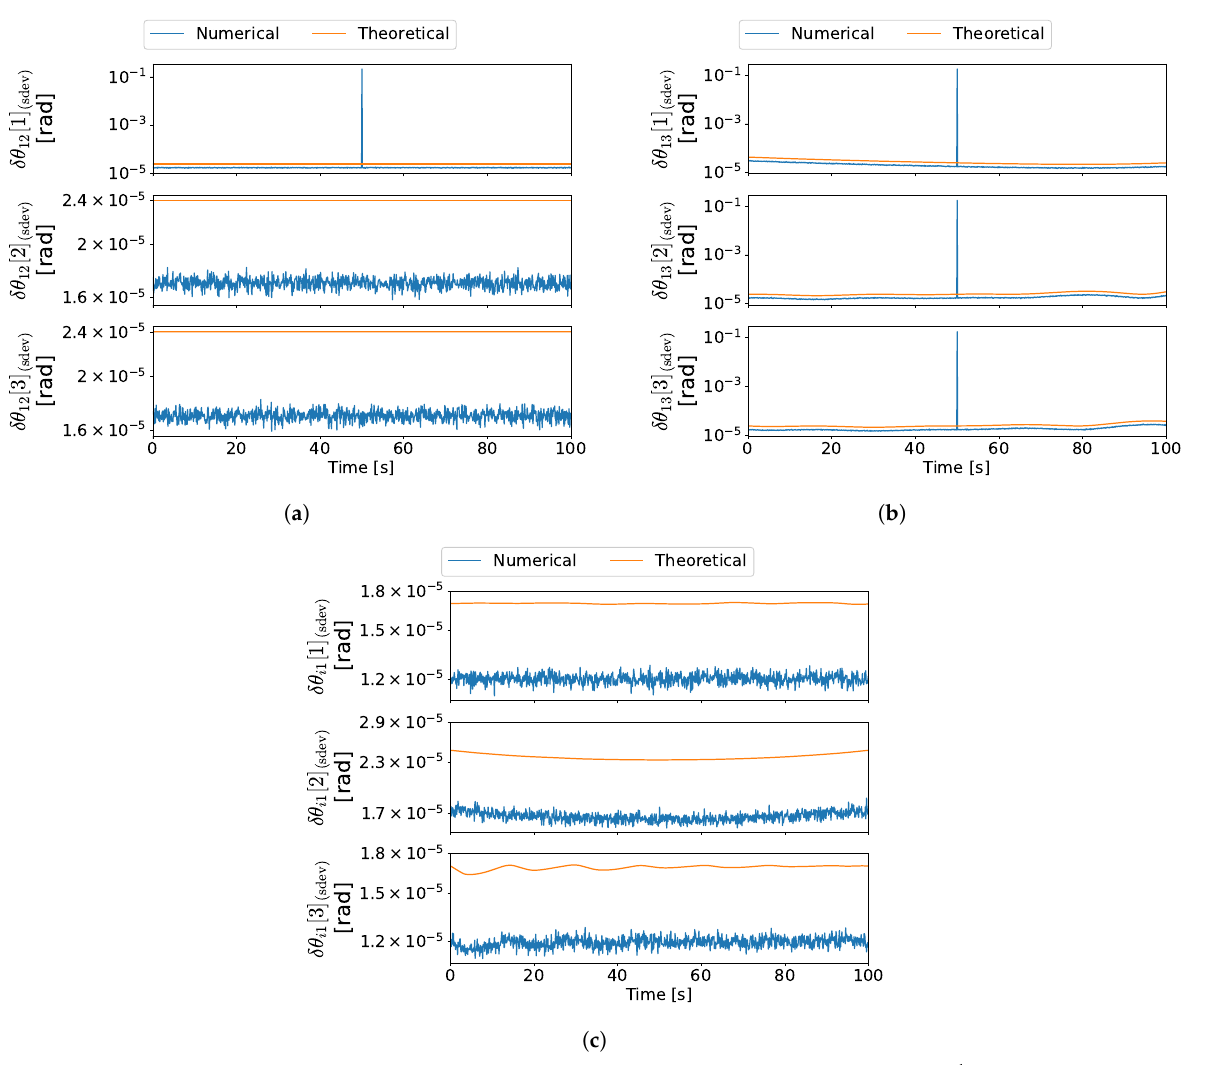
error standard deviation in 2 error standard deviation in 1